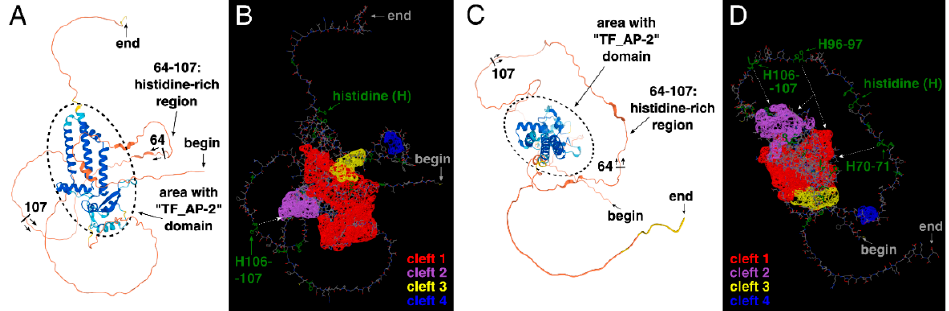
Figure 5. The three-dimensional structure of AP-2 δ visualized using AlphaFold and ChimeraX. The emphasis on the histidine-rich region is shown to spot its range, i.e., 64–107 aa; the helices mainly overlapping with the “TF_AP-2” domain are encircled ( A , C ). The location of “HH” patterns (two histidines in a row, marked in green) and the largest clefts (highlighted in red, purple, yellow, and blue) are shown ( B , D ). Both amino terminus (“begin”) and carboxyl terminus (“end”) of the protein are indicated.